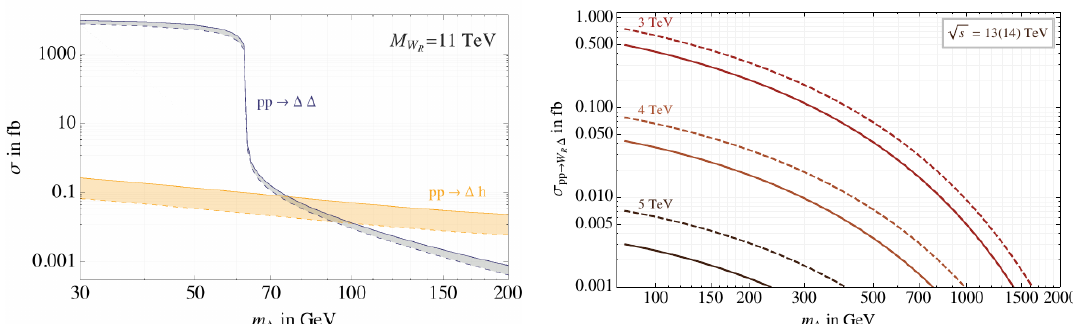
Figure 4 . Left: the pair (associated) production of (cid:1) in blue (yellow) through the Higgs portal at 13 TeV. Shading describes the variation of s (cid:18) from 5% in dashed to 10% in solid lines, M W 11 TeV. Right: cross-section for Drell-Yan production of W R (cid:1) for M W 13 (14) TeV in solid